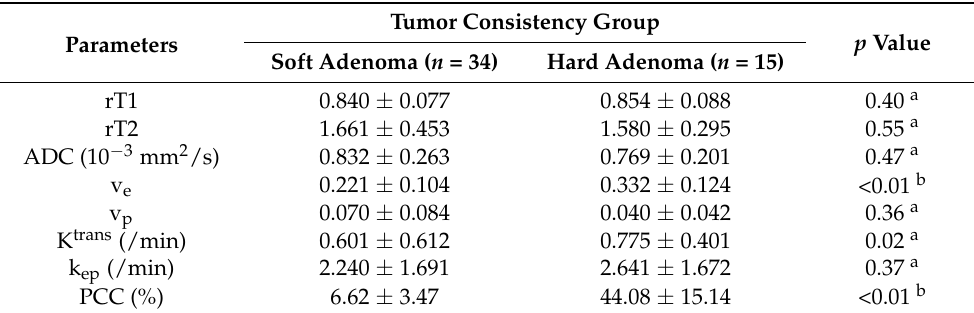
Table 6. MRI parameters and histologic percentage of collagen content of soft and hard adenomas of all adenomas.